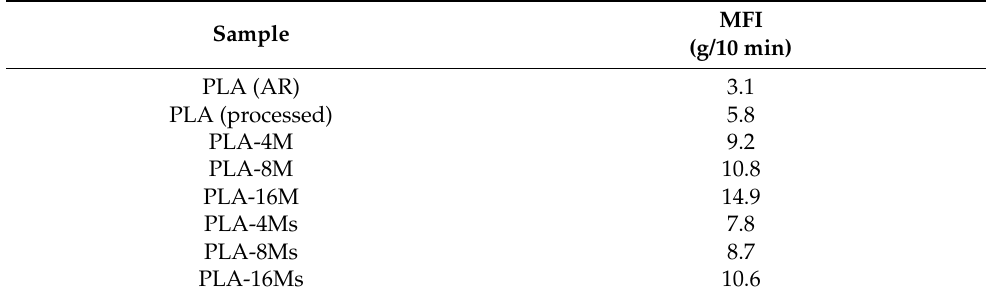
Table 4. Characterization of melt-flow index (MFI; 190 ◦ C, 2.16 kg) of PLA and PLA − magnetite nanocomposites.